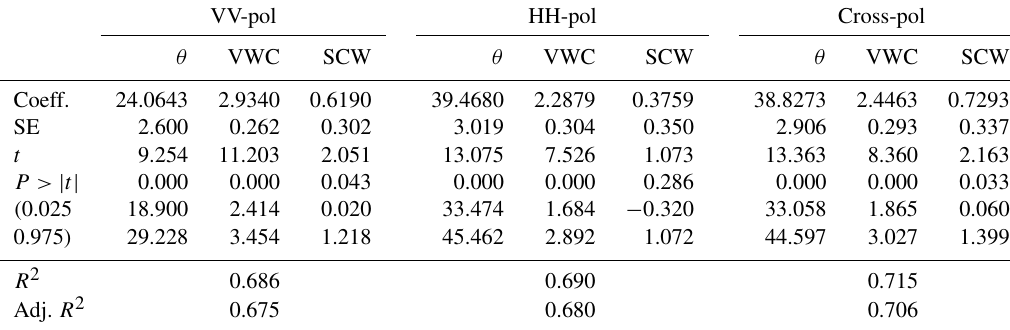
Table A4. Summary of multiple linear regression